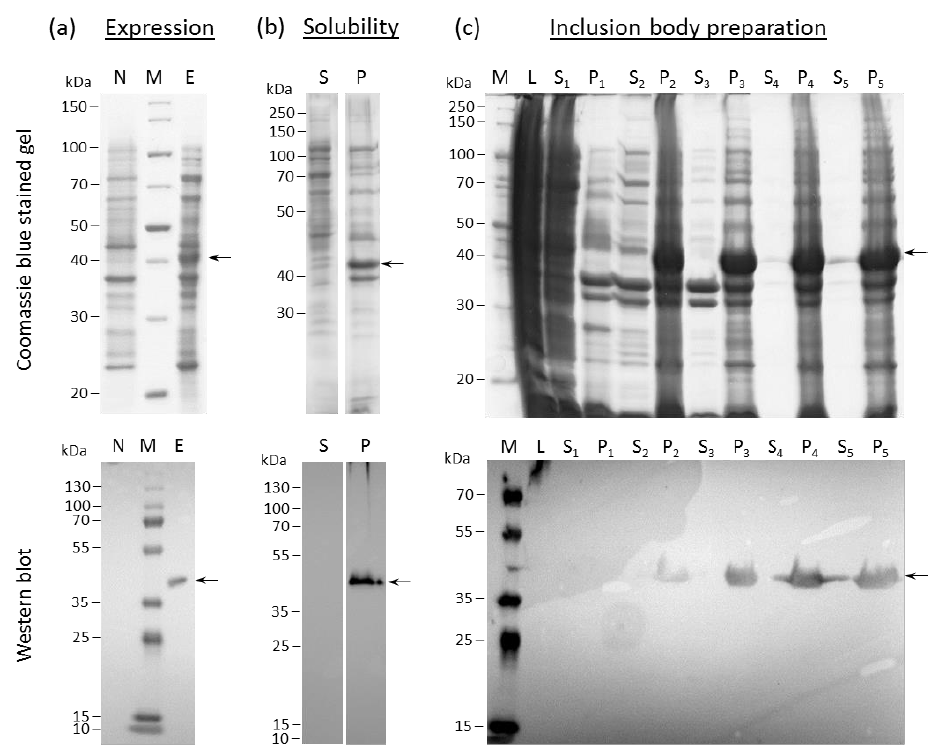
Figure 1. Coomassie brilliant blue-stained SDS-PAGE (top) and anti-His6 Western blot analysis (bottom) illustrating the expression, solubility, and inclusion-body preparation of K18(SU) from E. coli Rosetta (DE3). ( a ) Specific protein expression (E) in transformed bacterial cultures induced with 1 mM IPTG can be observed in comparison to non-induced control samples (N). ( b ) Analysis of pellet (P) and supernatant (S) after cell lysis and centrifugation revealed that K18(SU) was expressed in insoluble form. ( c ) Enrichment of K18(SU) through sequential washing steps (S: supernatants, P: pellets after centrifugation) during inclusion-body preparation can be observed in comparison to the bacterial lysate (L). M: Protein ladder (Coomassie blue-stained gels) or molecular weight marker standards (Western blots). Arrows point to the target protein.